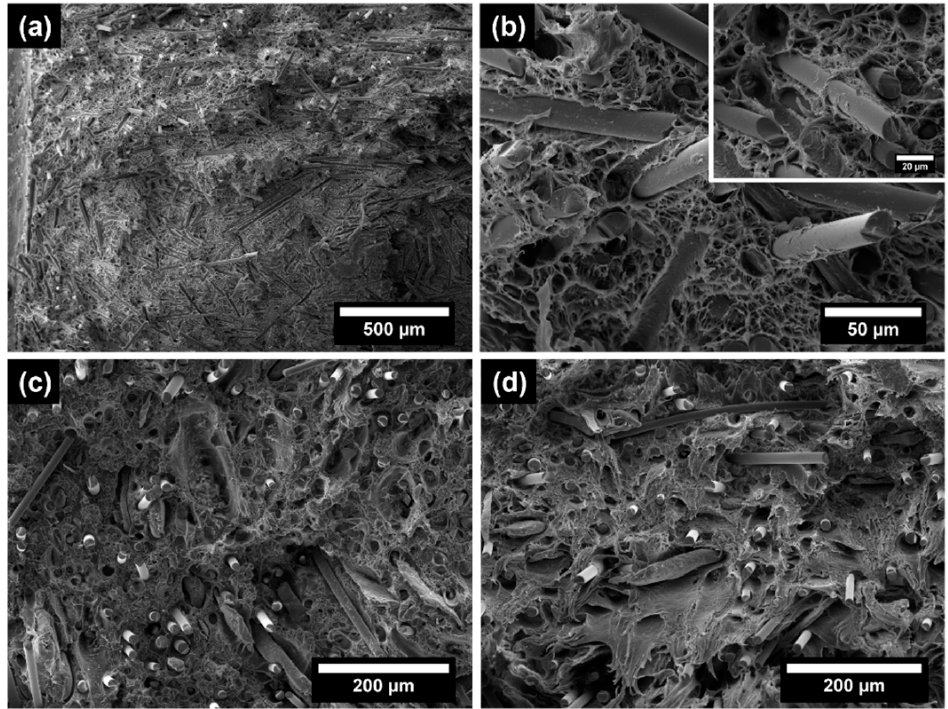
Figure 5. SEM micrographs of EcoAl_30BAS: ( a , b ) after Charpy impact test; ( c , d ) after tensile test.